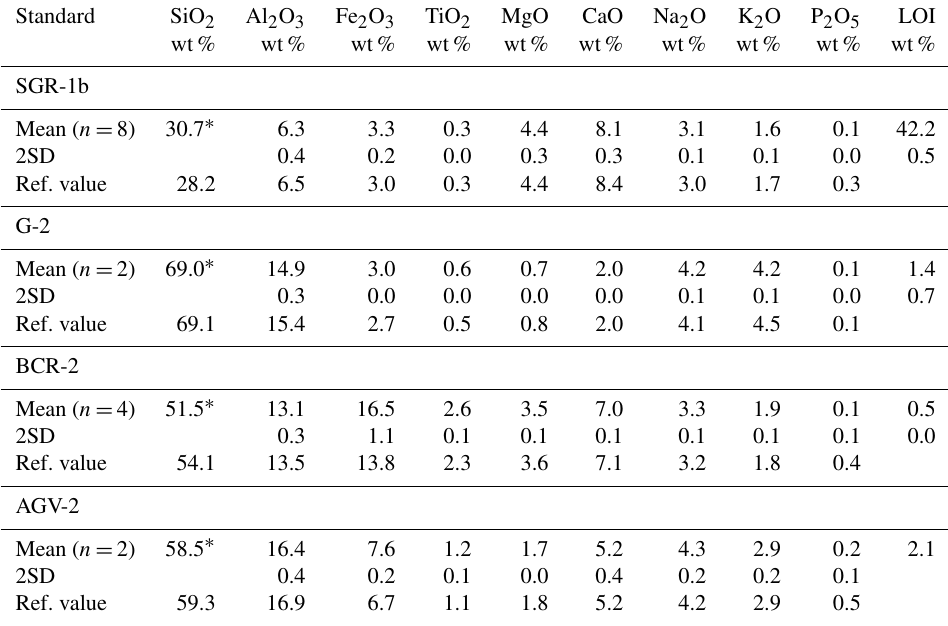
Table A4. Measurements of four USGS standards by ICP-MS compared to literature values ∗ . Concentrations are in mgkg − 1 . Standard Mn Rb Sr Ba La Ce Pr Nd Sm Eu Gd Tb Dy Ho Er Tm Yb Lu Sco-1 Mean ( n = 12) 431 115 160